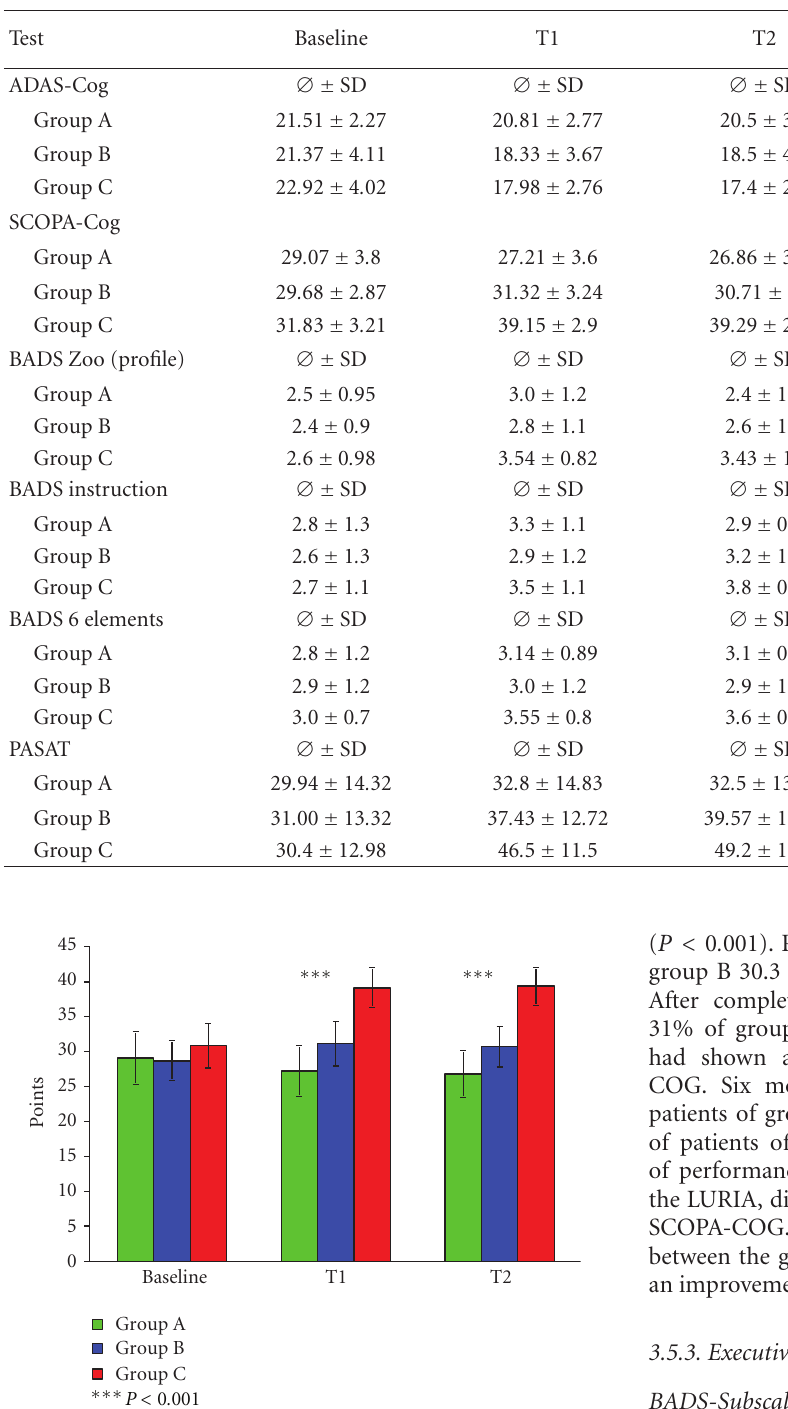
Figure 2: Group C improved significantly more on the SCOPA- COG test than group A and